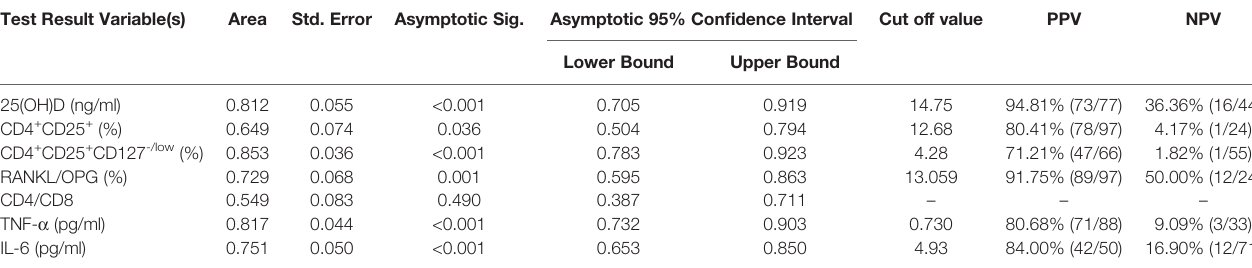
TABLE 3 | PPV and NPV of clinical indicators from the ROC curve to predict the occurrence of osteoporosis. Test Result